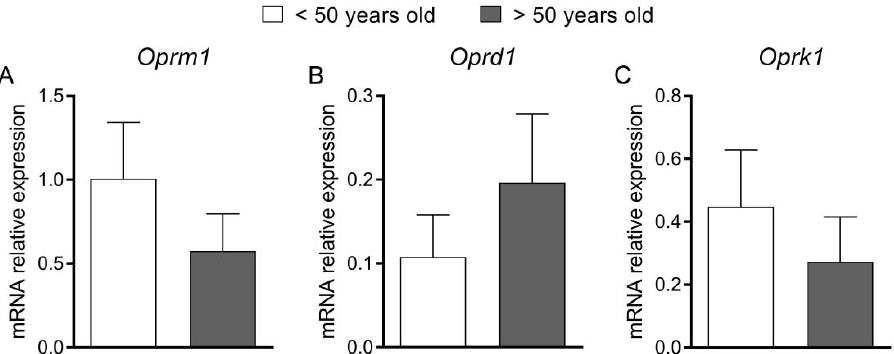
Figure 6. The mRNA expression of the Opmr1 ( A ), Oprd1 ( B ) and Oprk1 ( C ) in the mucosal biopsies from the descending part of the colon from patients with constipation that were divided into two age groups: below 50 and over 50 years old. The difference between 2 groups was assessed with standard t ‐ test, as the normality of data was not violated and variance homogeneity was proved.